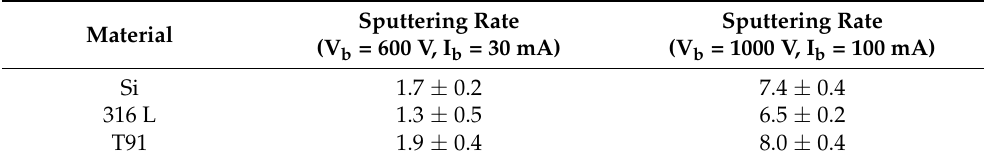
Table 2. Measured sputtering rates in µ m/hour using a Kaufman Ion Gun on Si, 316 L, and T91 steel samples, as a function of beam voltages and ion currents corresponding to approximately 50% (middle column) and 95% (last column) of total available power.